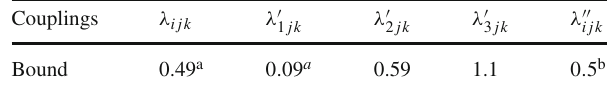
Table 1 The bounds on the most constrained coupling for each class of RPV operators at M W . The bounds are given for sfermion masses ˜ m of 1TeV and typically scale as ˜ m − 1 . A complete list with the specific sfermion mass dependence is given in Appendix A. a We disregarded the stringent bound on λ 133 and λ (cid:4) arising from upper bounds on 133 and λ (cid:4)(cid:4) can be more strongly constrained neutrino masses [35]. b λ (cid:4)(cid:4) 112 113 undertheassumptionofalargehadronicscalefordoublenucleondecay [36]